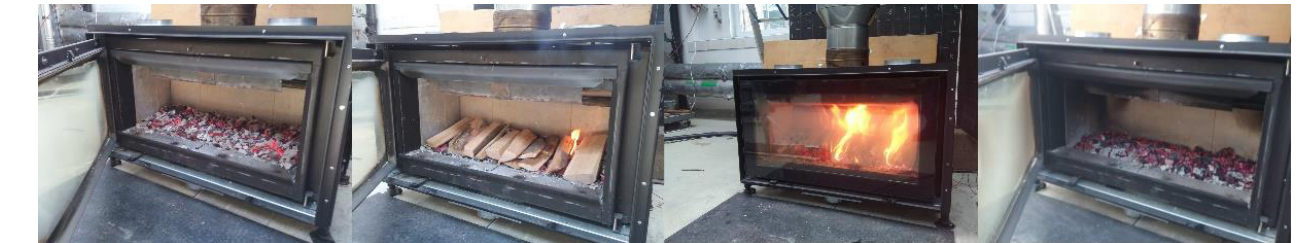
Figure 1. The course of the phases of the combustion process during measurement.